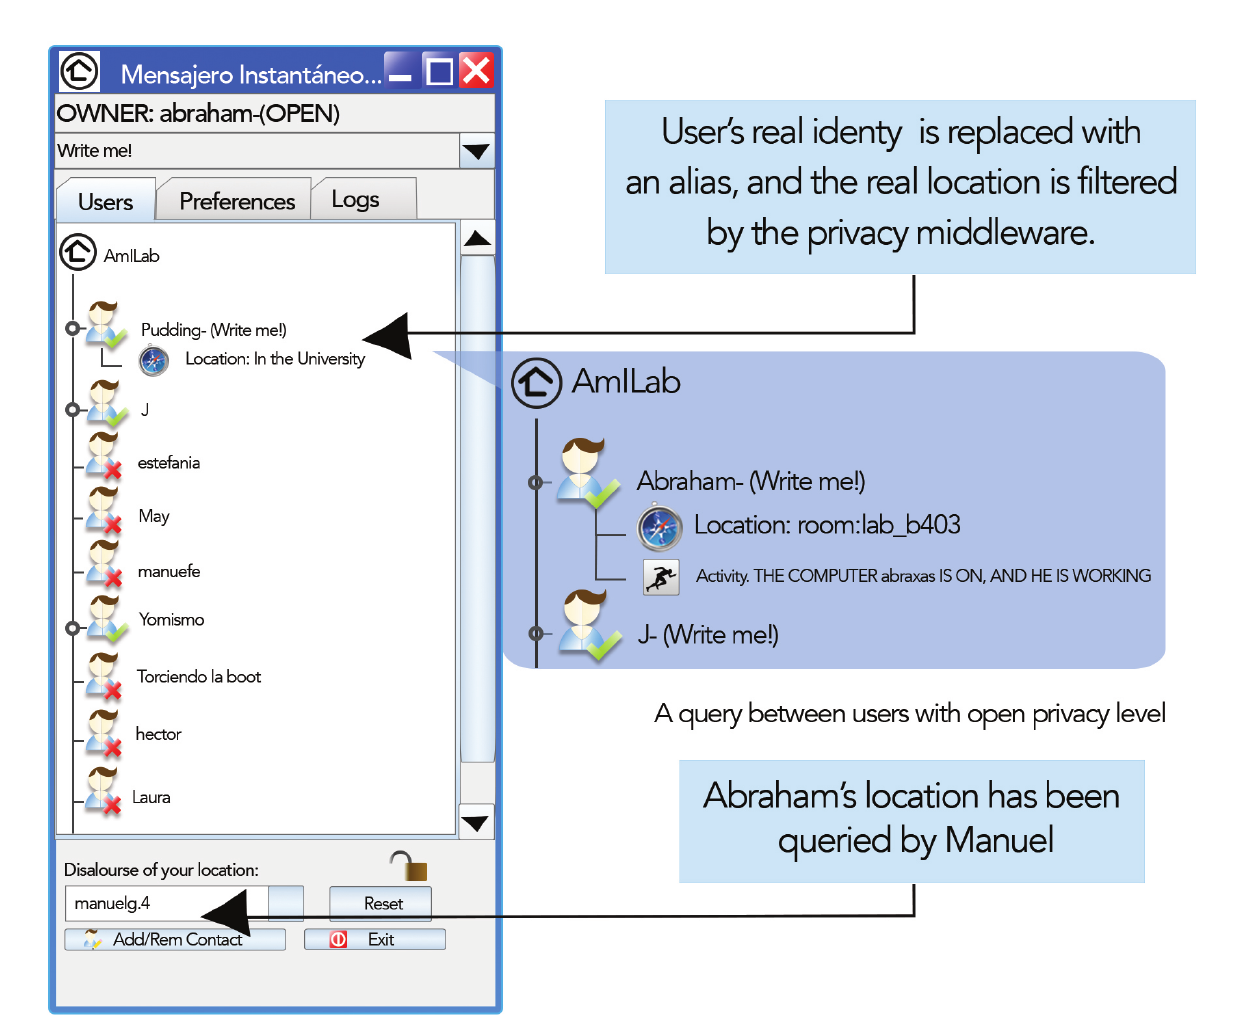
Figure 4. Instant